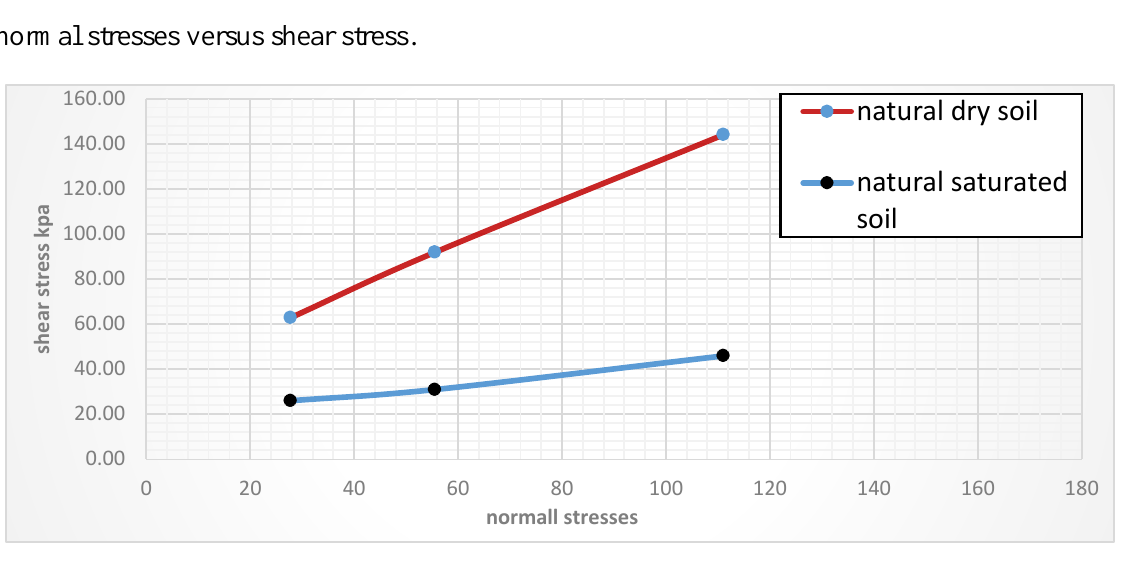
Fig. 9. Relationship between shear stress and normal stress for natural soil, from direct shear test for dry and soaked